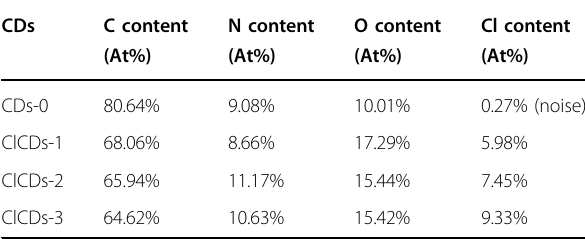
Table 1 Elemental compositions of the four CDs determined by an XPS